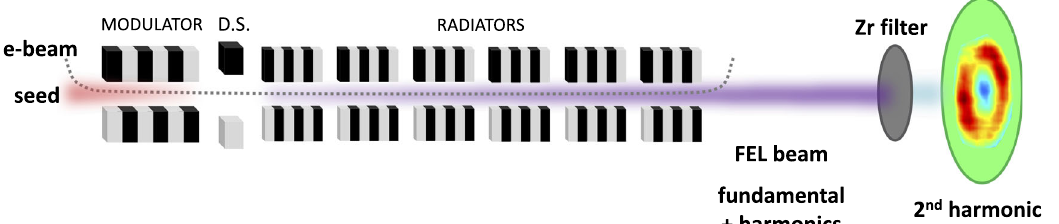
FIG. 1. Generation of coherent optical vortices through nonlinear harmonic generation at a FEL (not to scale). A transversely Gaussian seed density modulates the e-beam using a combination of an undulator (modulator) and a dispersive section (D.S.) so that it emits coherent XUV light in the radiator. The interaction between FEL radiation at the fundamental wavelength and the e-beam induces bunching at the second harmonic, which is amplified along the radiator chain, leading to emission of intense, coherent optical vortices in the XUV spectral range. A Zr filter is placed at the FEL output to suppress the fundamental Gaussian mode, transmitting only the optical